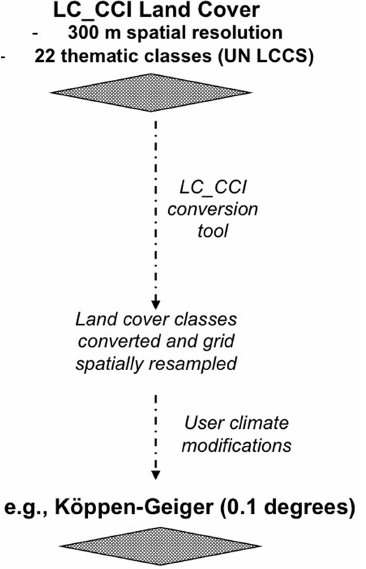
Figure 2. The LC_CCI land cover conversion tool processing chain requires converting the thematic legend and resampling the grid res- olution to user defined PFT and coordinate system. Independent of the LC_CCI tool, users can append climate classes to the PFT ag- gregation.